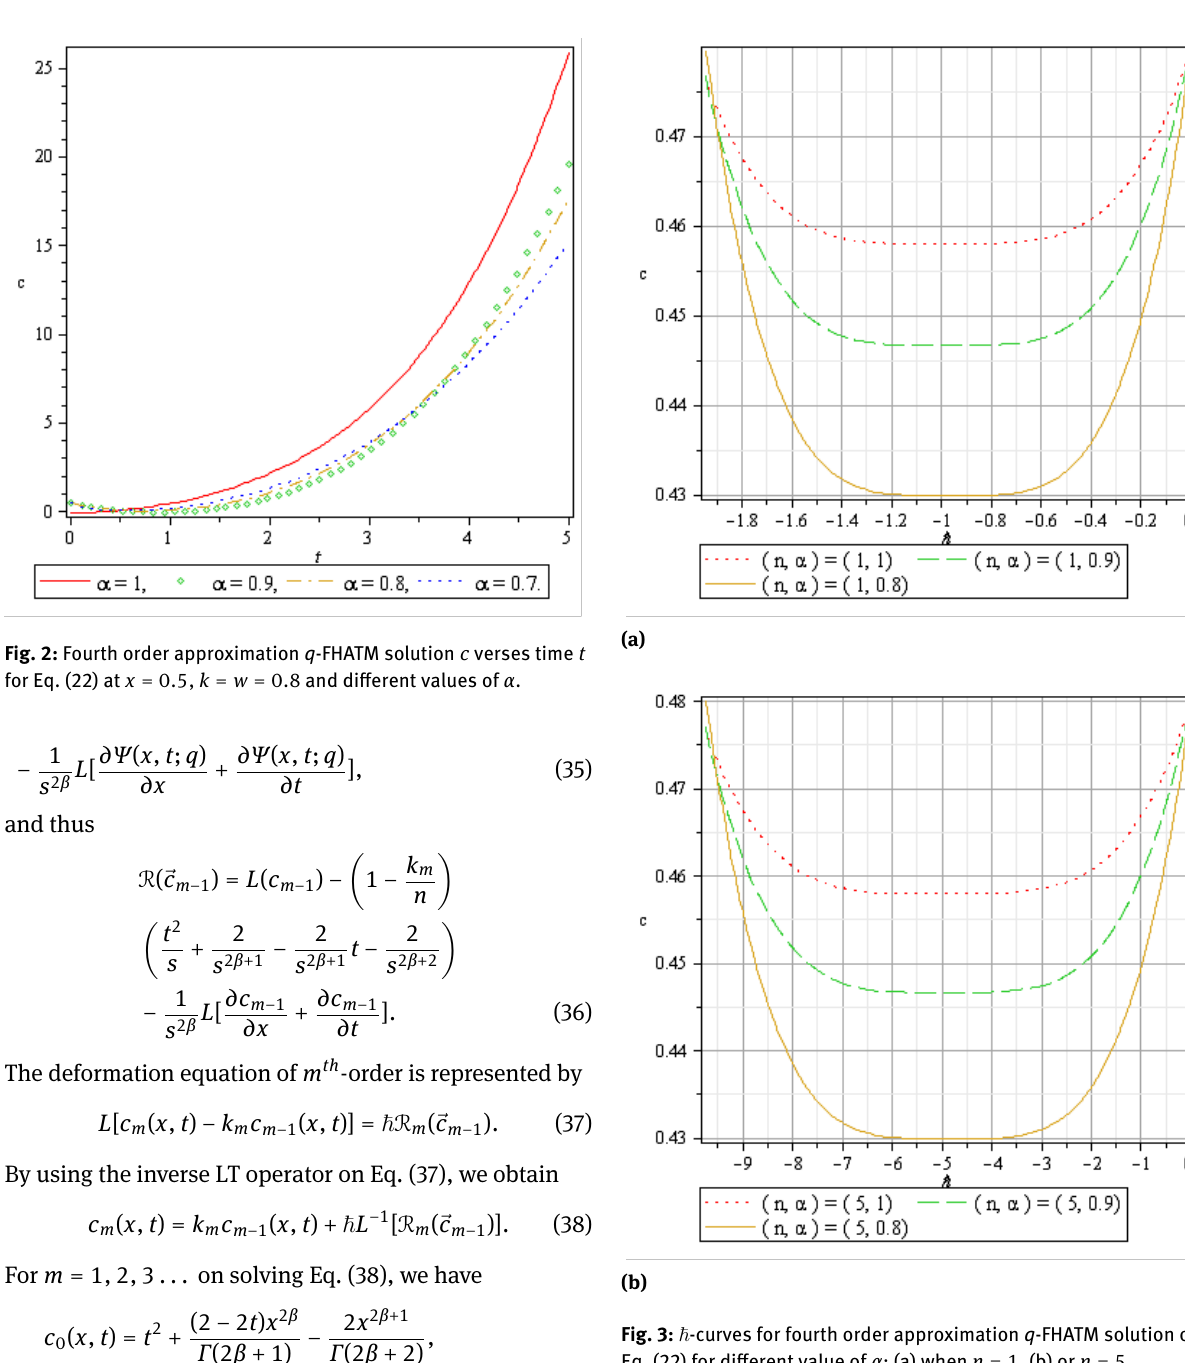
If we put (cid:126) = −1 and n = 1 in (40), then we arrive at the results obtained by HPM, DTM, RDTM, HPTM, LDM and ADM. The advantages of q -HATM over HAM, HPM, DTM, RDTM, HPTM, LDM and ADM is that q -FHATM contains two parameters namely asymptotic parameter n and auxil- iary parameter (cid:126) therefore we can easily settle and restrict the region of convergence of series solution derived with the aid of q -FHATM by choosing suitable values of (cid:126) and